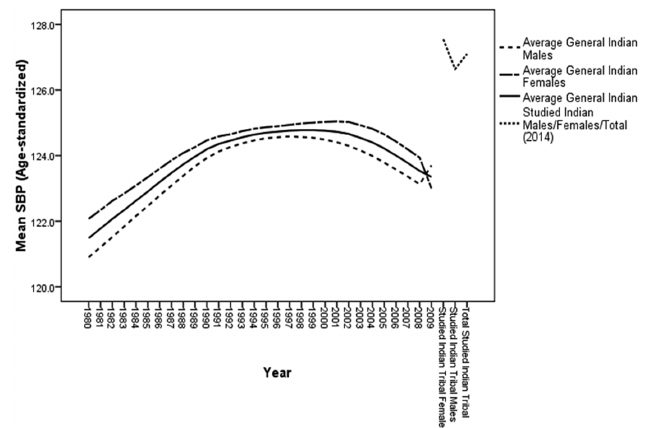
Fig 3. 30-year trend of systolic blood pressure (SBP) of general Indian population compared to its present status among the tribal population.